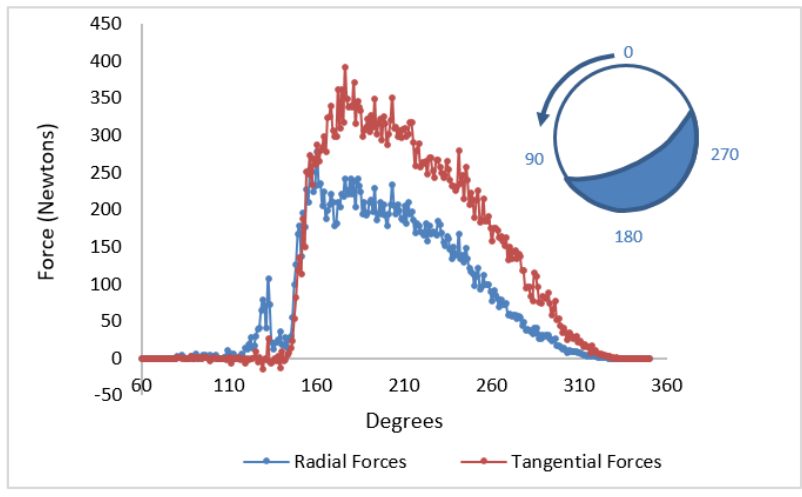
Figure 2. Radial and tangential forces acting on the shell liners.